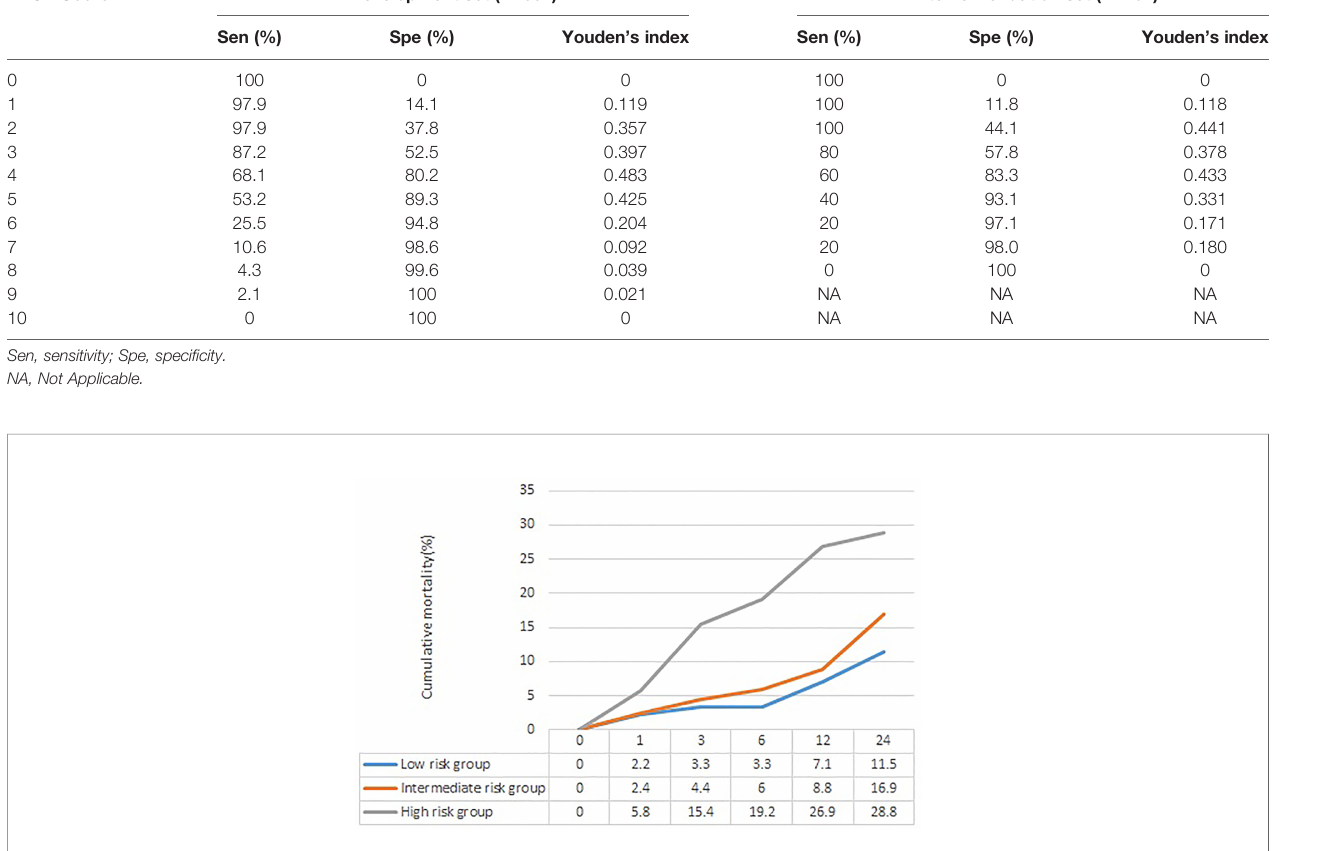
TABLE 4 | The sensitivities, speci fi cities, and Youden ’ s index of the AUPA score for evaluating the short-term outcome in community acquired pneumonia patients with diabetes. APUA Score Development set (N=531) External validation set (N=107)